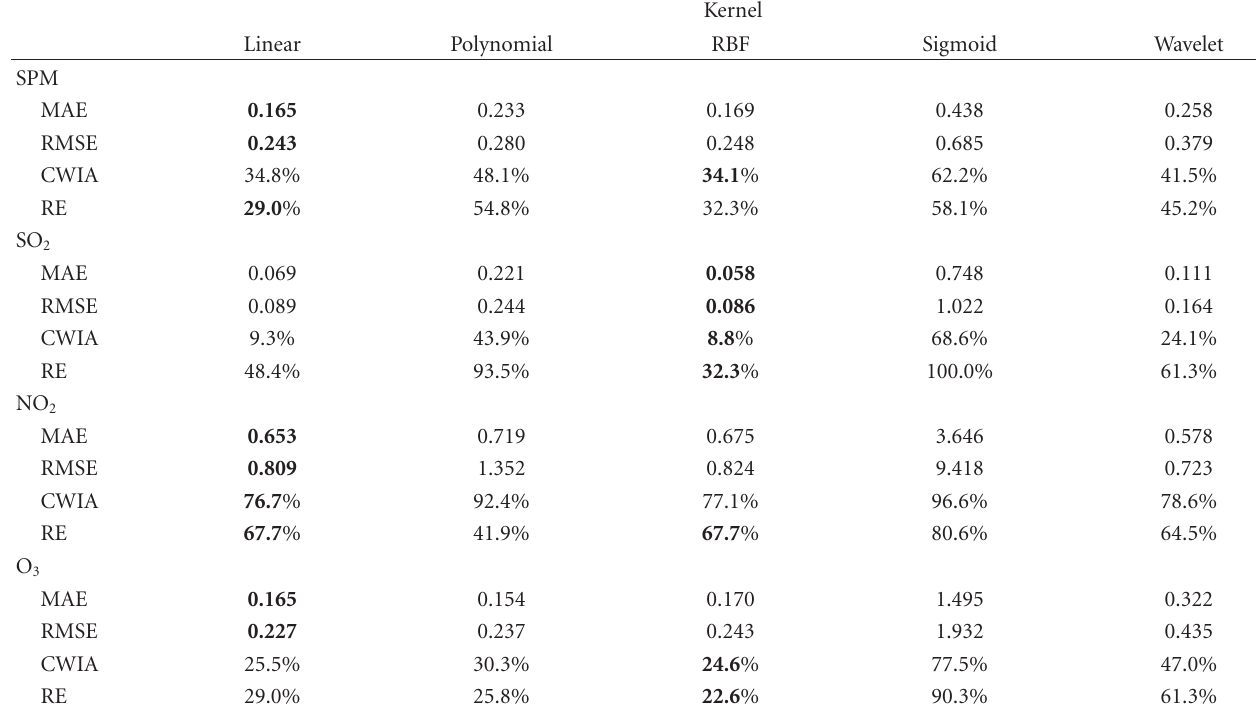
Table 6: The tested results of SPM, SO 2 , NO 2 , and O 3 in di ff erent kernel models in summer experiment.